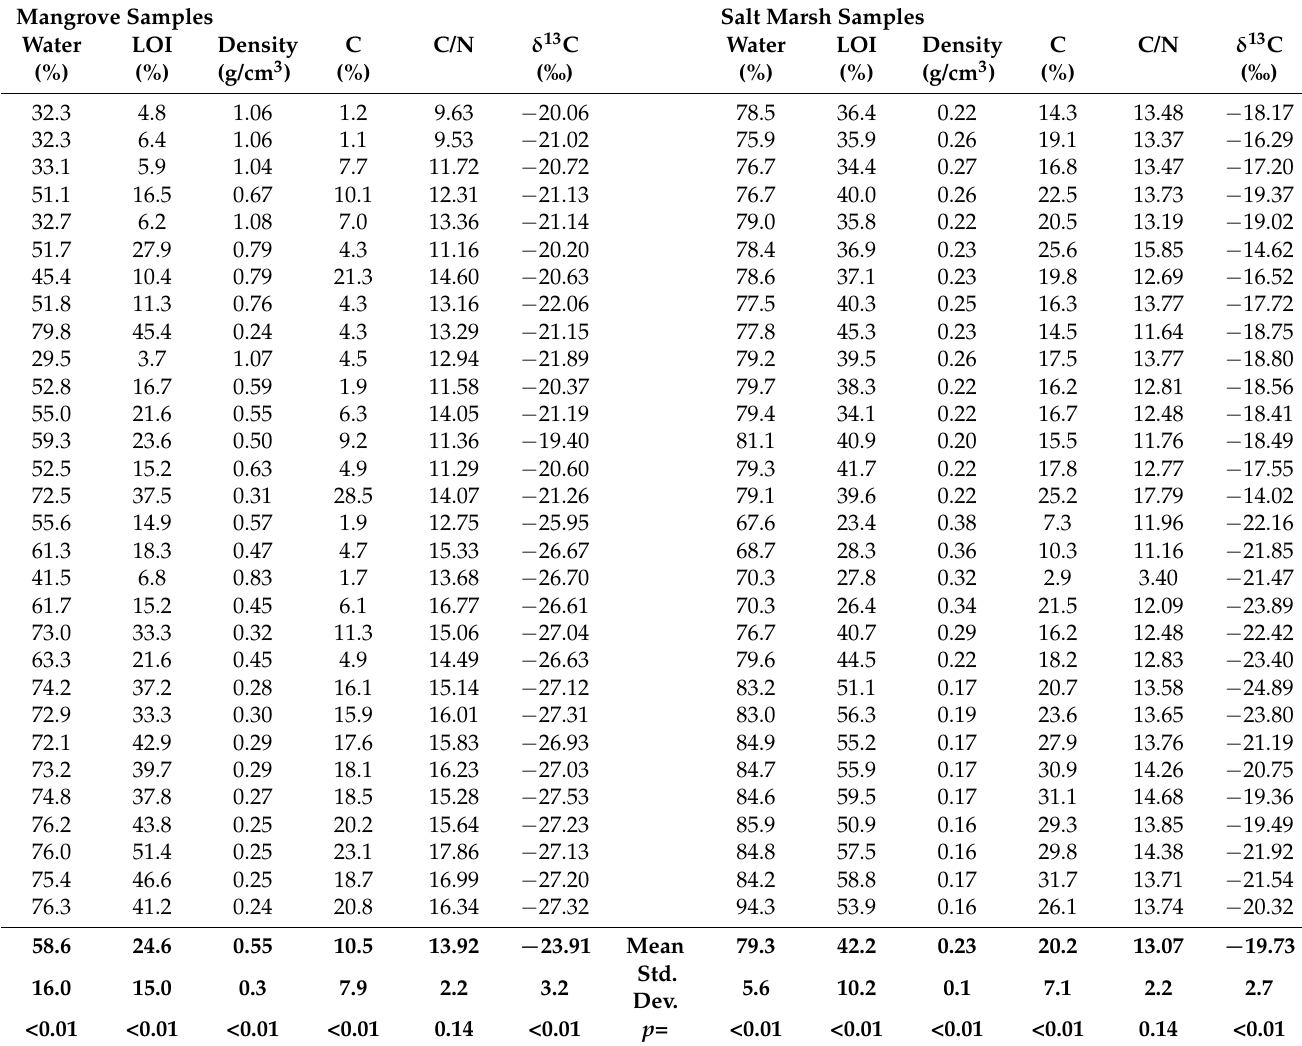
Table 1. Surface sample percent water content, percent loss on ignition (LOI), percent carbon content, C/N ratio, and δ 13 C values are presented for salt marsh and mangrove surface sediment samples along with mean values, standard deviations, and significance values ( p ) for differences between salt marsh and mangrove samples (from t -tests). Mangrove C/N was not significantly different than salt marsh C/N, but all other variables were significantly different ( p < 0.01). A Bonferroni Correction was used to counteract the problem of multiple comparisons (see methods).